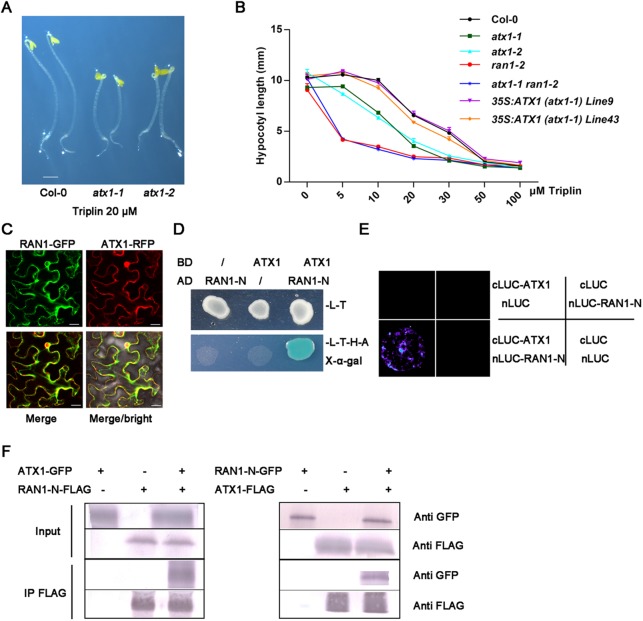
The copper chaperone ATX1 interacts with RAN1.(A) atx1-1 and atx1-2 are hypersensitive to triplin. The phenotypes of 3-day-old, dark-grown Col-0, atx1-1 and atx1-2 seedlings treated with 20 μM triplin are shown. Scale bar represents 1 mm. (B) Hypocotyl lengths of 3-day-old, dark-grown seedlings of Col-0, atx1-1, atx1-2, ran1-2, atx1-1 ran1-2 and two 35S:ATX1-GFP (atx1-1) transgenic lines treated with different doses of triplin are shown. Each experiment was repeated three times, more than 30 seedlings were used every time. Error bars represent SEM. (C) Subcellular co-localization of ATX1 and RAN1. ATX1-RFP and RAN1-GFP were transiently expressed in N. benthamiana leaves and observed and imaged under a confocal microscope. Scale bars represent 20 μM. (D) ATX1 interacted with RAN1 in yeast two-hybrid assay. ATX1 was fused to a GAL4 DNA-binding domain (BD) and RAN1-N (289 amino-terminal amino acids of RAN1) was ligated to a GAL4 activation domain (AD). The protein interactions were examined on cells grown on synthetic dropout (-Leu/-Trp/-His/-Ade) medium plus X-α-Gal (50mg/L) plates for 3 days. (E) Bimolecular fluorescence complementation assays showed interaction between ATX1 and RAN1 using the split luciferase system. Nicotiana benthamiana leaves were infiltrated with agrobacteria containing different construct combinations harboring both the C- and N-terminal of the luciferase fused to either ATX1 and RAN1-N or just one of them (controls). (F) Co-Immunoprecipitation assays showed interaction between ATX1 and RAN1. Nicotiana benthamiana leaves were infiltrated with agrobacteria containing ATX1-GFP/FLAG and RAN1-N-FLAG/GFP or just one of them (controls). The protein extracts were immunoblotted with anti-FLAG antibody or anti-GFP antibody.